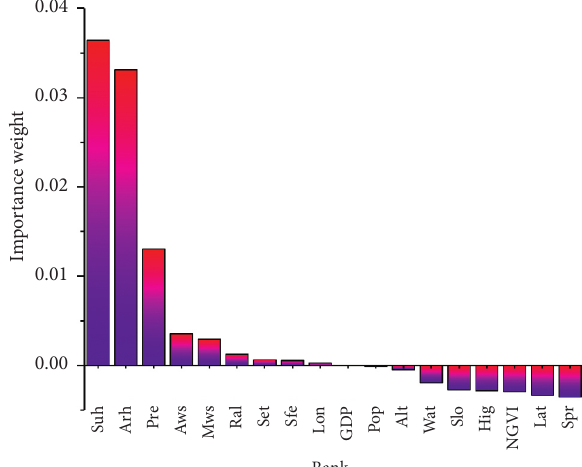
Figure 3: Important ranking of the 19 feature subsets.